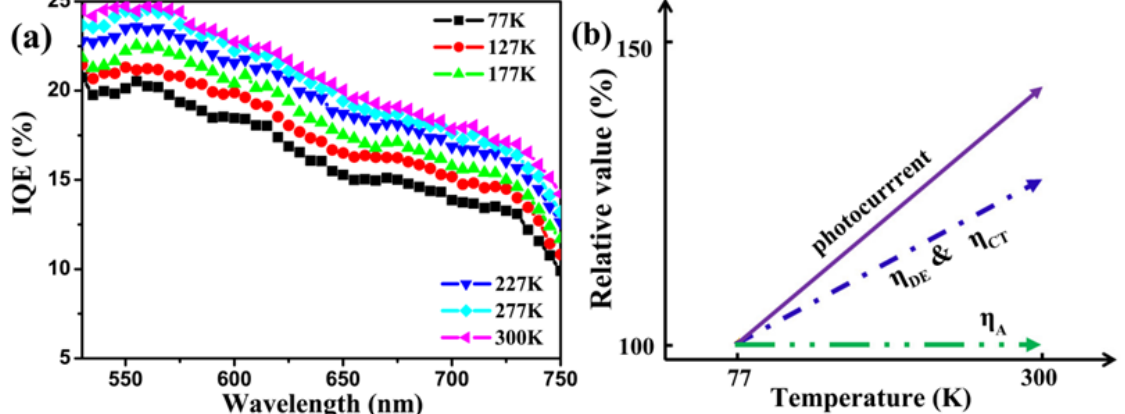
Figure 5. ( a ) Calculated IQE spectra of the developed device at different temperatures; ( b ) Schematic drawing showing absorption efficiency ( η A ) , exciton diffusion ( η ED ) and dissociation efficiency ( η CT ), carrier mobility and photocurrent trends versus temperature. 77 K was chosen as the reference temperature.